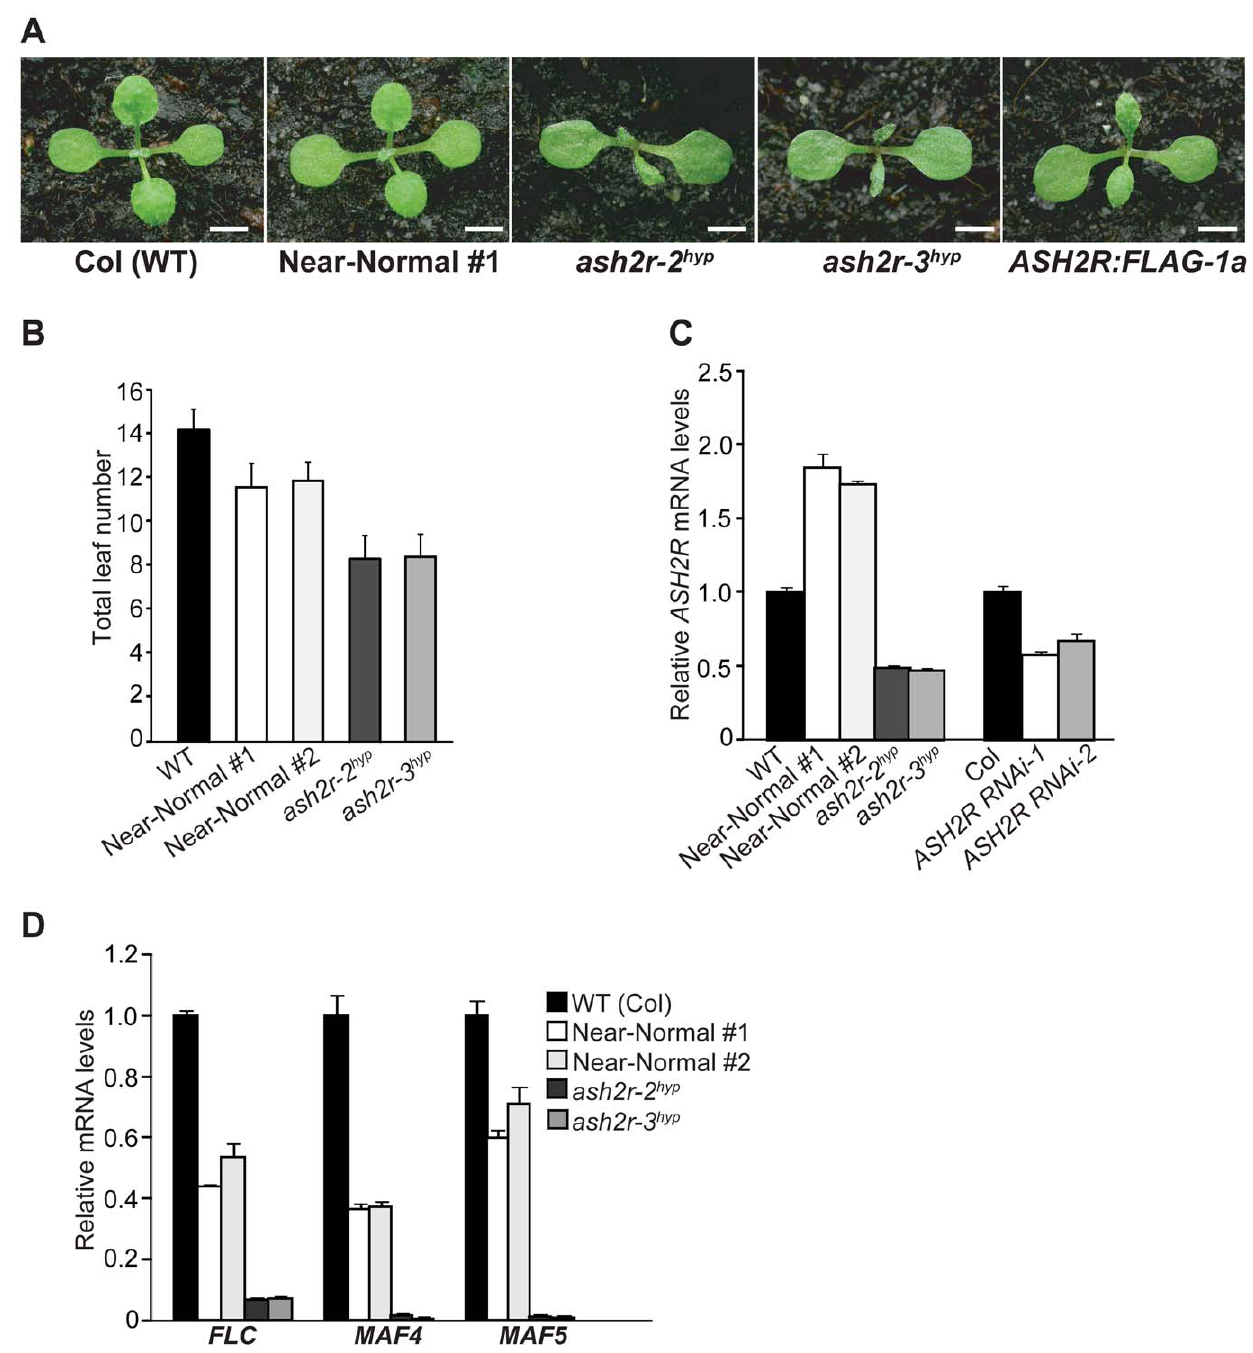
Figure 4. Characterization of the Hypomorphic ash2r Mutants. (A) Phenotypes of the hypomorphic ash2r mutant seedlings (T 3 generation) grown in LD. On the right is an ASH2R:FLAG-1a (T 3 ) seedling with a leaf phenotype. Bars indicate 2.0 mm. (B) Flowering times of the hypomorphic ash2r mutants grown in LD. For each line, 12–15 plants were scored. Error bars indicate SD. (C) Relative mRNA levels of the ASH2R transgene in the shoot apices of 10-d-old seedlings of the indicated lines. The transcript levels were determined by real-time quantitative PCR. Relative expression to wildtype Col is presented. Bars indicate SD. (D) Relative mRNA levels of FLC , MAF4 and MAF5 in the shoot apices of 10-d-old seedlings of the indicated lines.